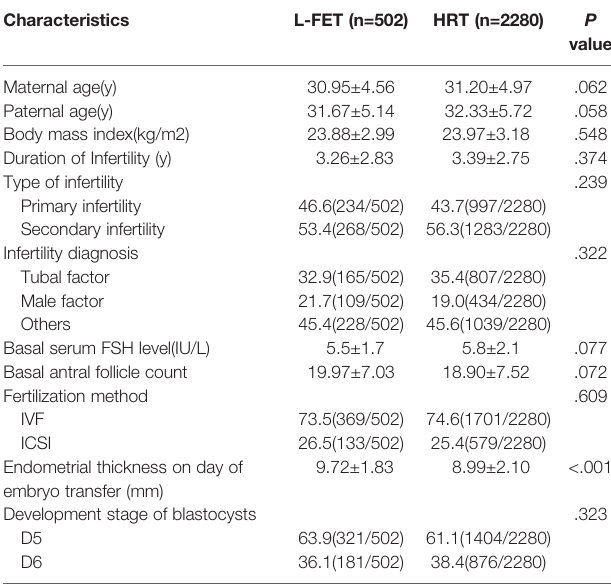
TABLE 1 | Basic characteristics for cycles from 2017 through 2019.